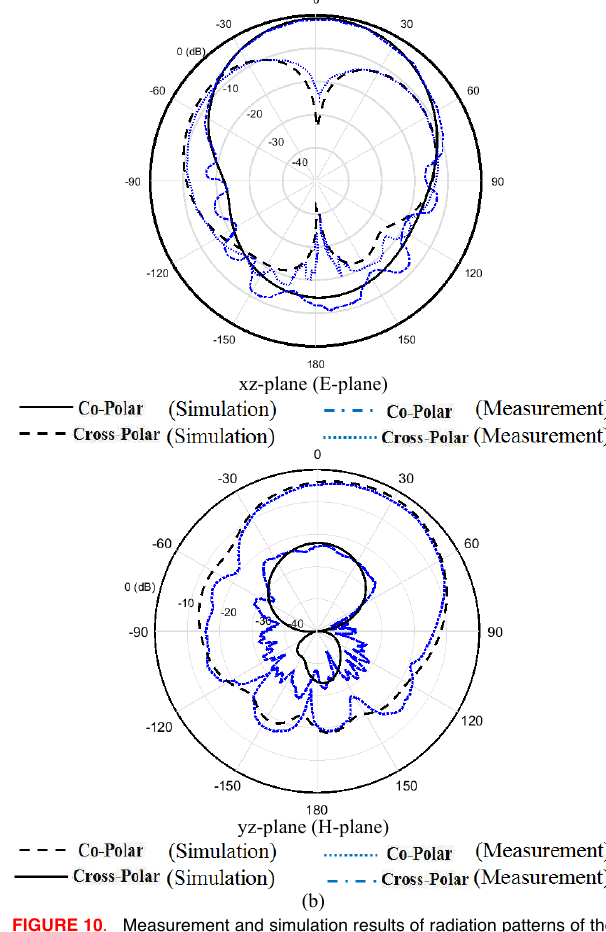
FIGURE 10 . Measurement and simulation results of radiation patterns of the suggested half design with half V-shaped slot at (a) 5 GHz (b) 15.5 GHz.